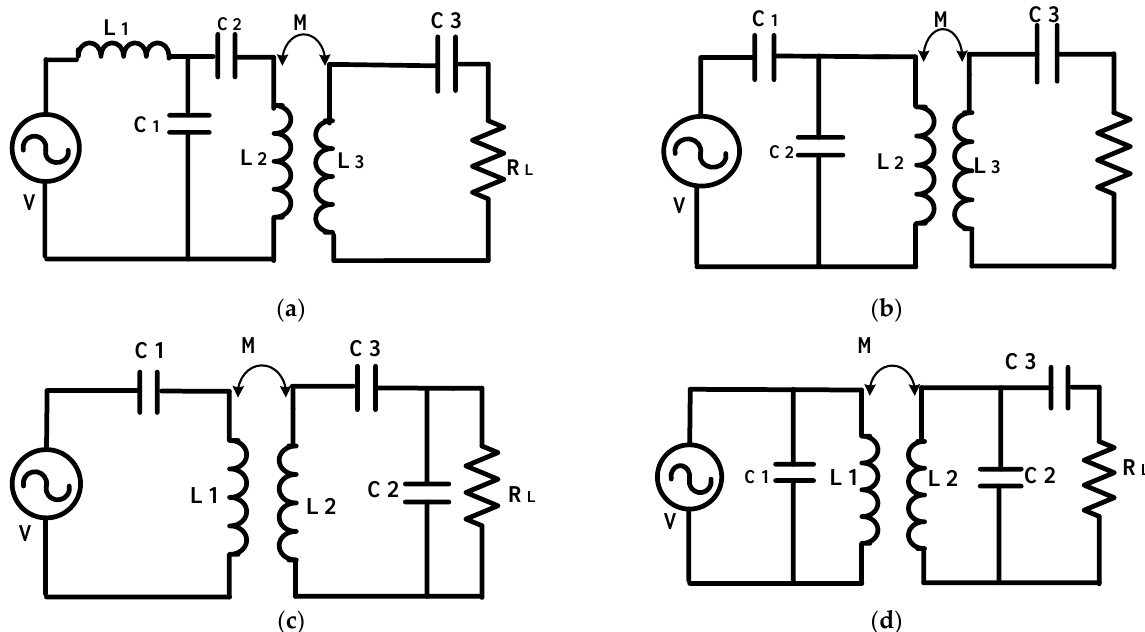
Figure 6. Equivalent circuits of hybrid compensation topologies. ( a ) LCC-S, ( b ) SP-S, ( c ) S-SP, and ( d ) P-PS.